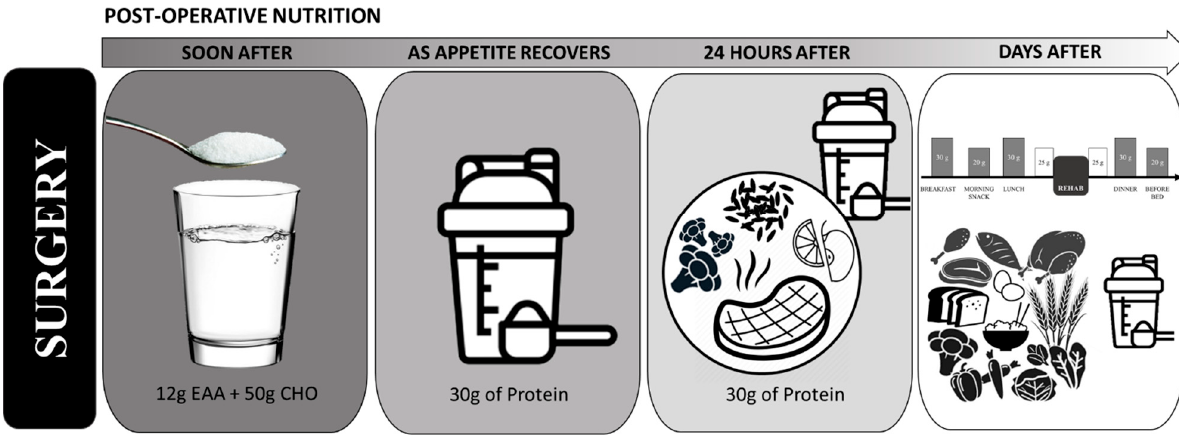
Figure 3. Example of post-operative nutrient timing. Partially adapted from Smith-Ryan et al. (2020).